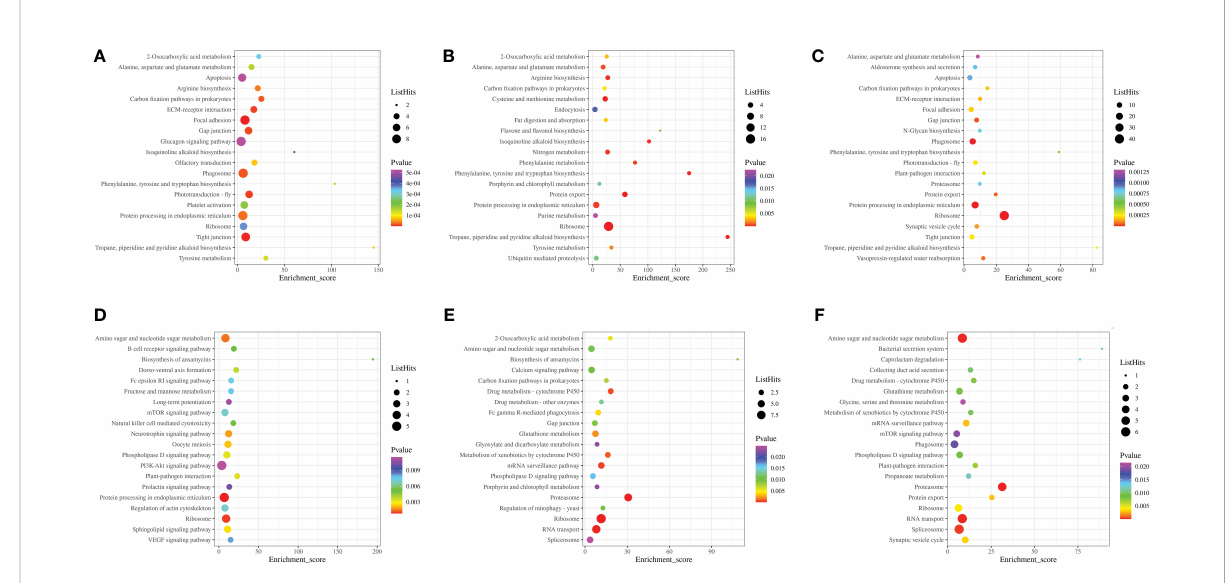
FIGURE 12 Results of Top 20 KEGG pathways enrichment for Macrobrachium nipponense exposed to different salinity gradients in the gills (A – C) , and hepatopancreas (D – F) at 7, 14 and 21 ppt comparison treatments,